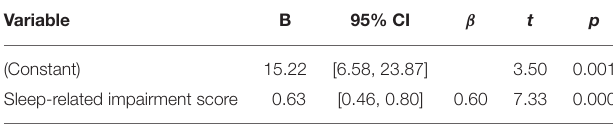
TABLE 3 | Regression analysis for sleep-related impairment and